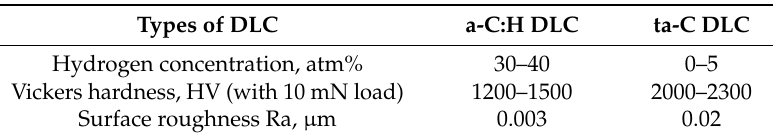
Table 1. Properties of the DLC